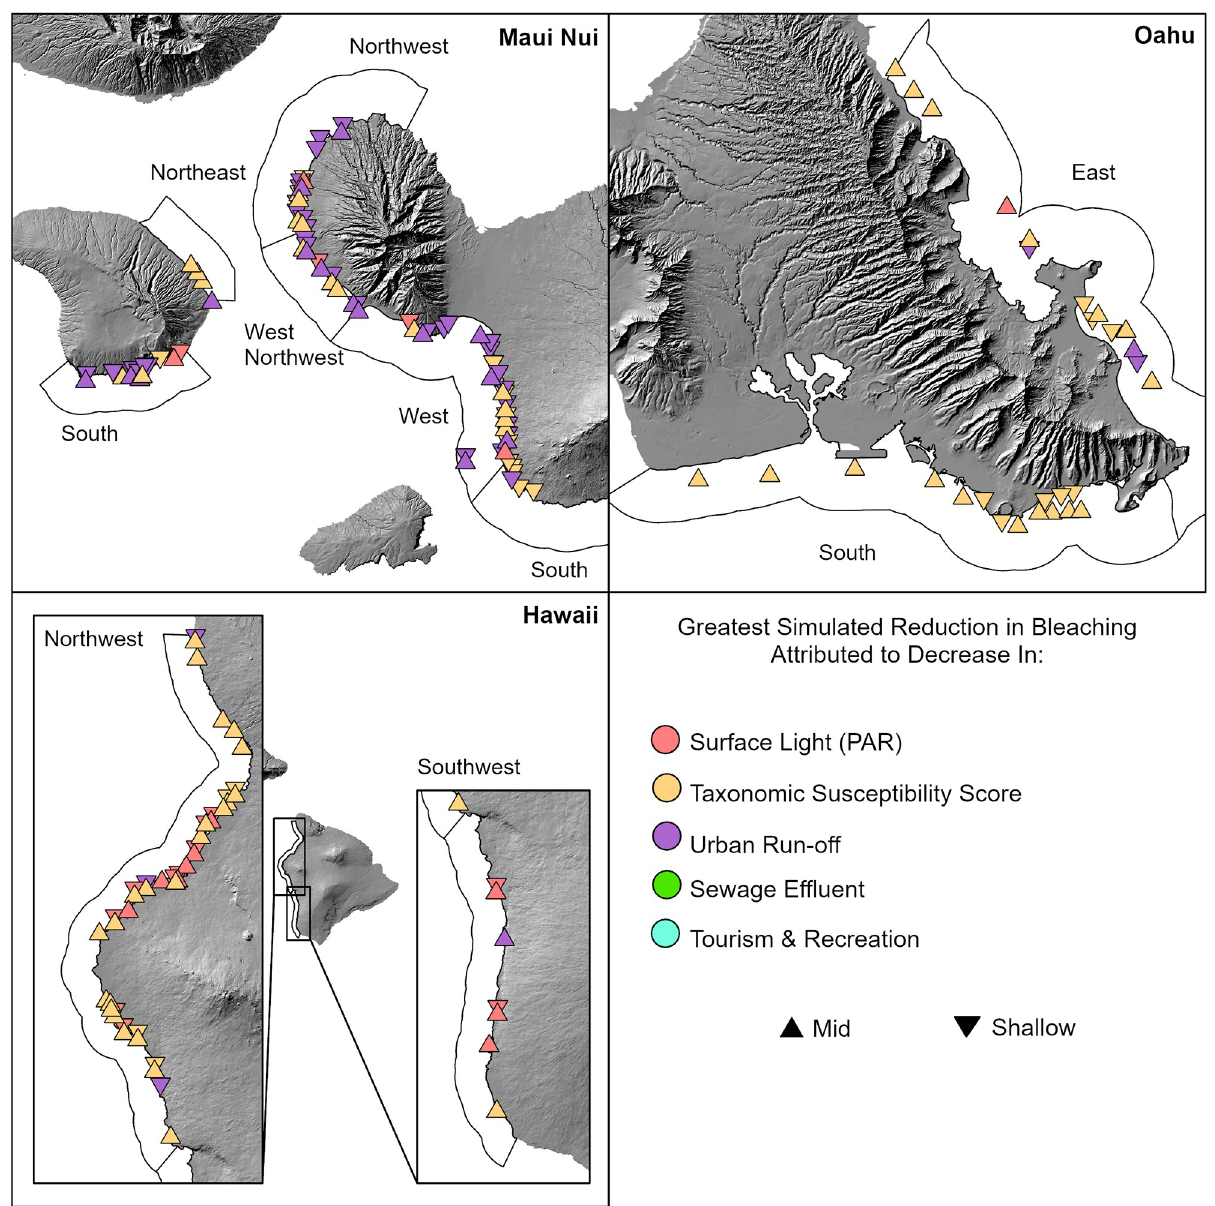
Fig 8. Potential site-specific management actions to reduce bleaching under simulated thermal stress using best-fit model. Colors reflect the variable found to result in the largest decrease in predicted bleaching (%) at the site-level under model perturbations, wherein all variables were in turn reduced by 1 SD as other variables were held at observed values. Only variables that could feasibly be managed were perturbed (surface light (PAR), sewage effluent, urban run-off, susceptibility, and tourism/recreation). See S8 Table for driver variable